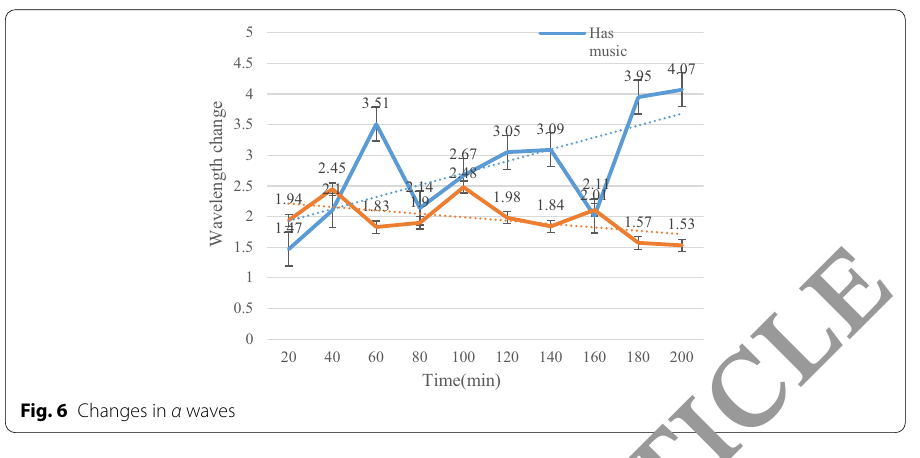
Table 5 Correlation between drivers’ overall EEG indicators and driving time Pearson correlation **p < 0.05 means there is a difference, p < 0.01 means there is a significant difference